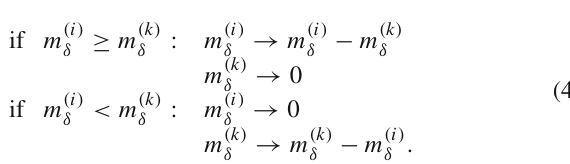
Fig. 2 Comparing four-momentum and constituent background sub- traction for R = 0 . 4 anti- k ⊥ jets from a di-jet sample at ( jet ) > 100 GeV and | η ( jet ) | < 2 . 5: relative difference 2 . 76 TeV with p ⊥